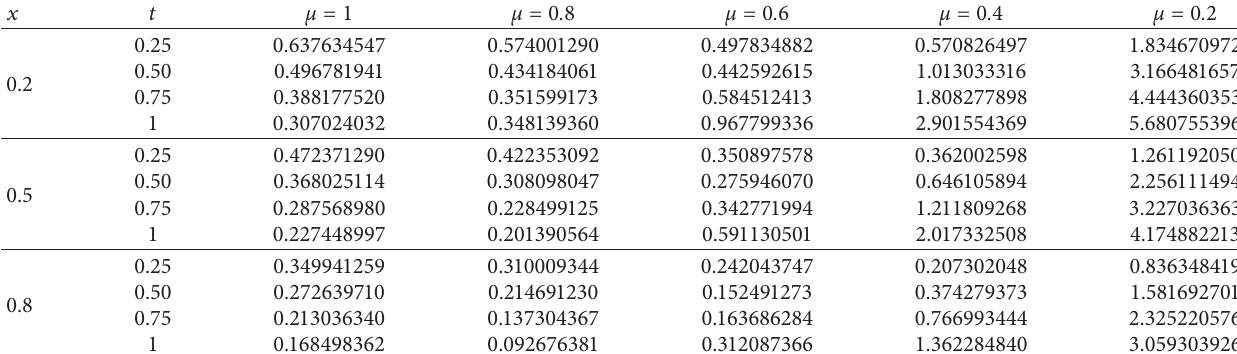
Table 4: Numerical values for v ( t , x ) of equation (45) for different values of t and x .